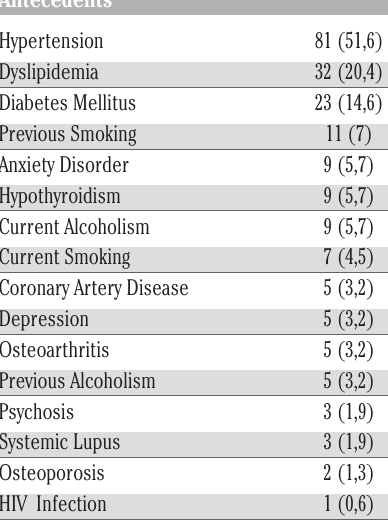
Table 2. Comorbidities and pathological antecedents of patients seen at the neurol- ogy outpatient clinic (n =